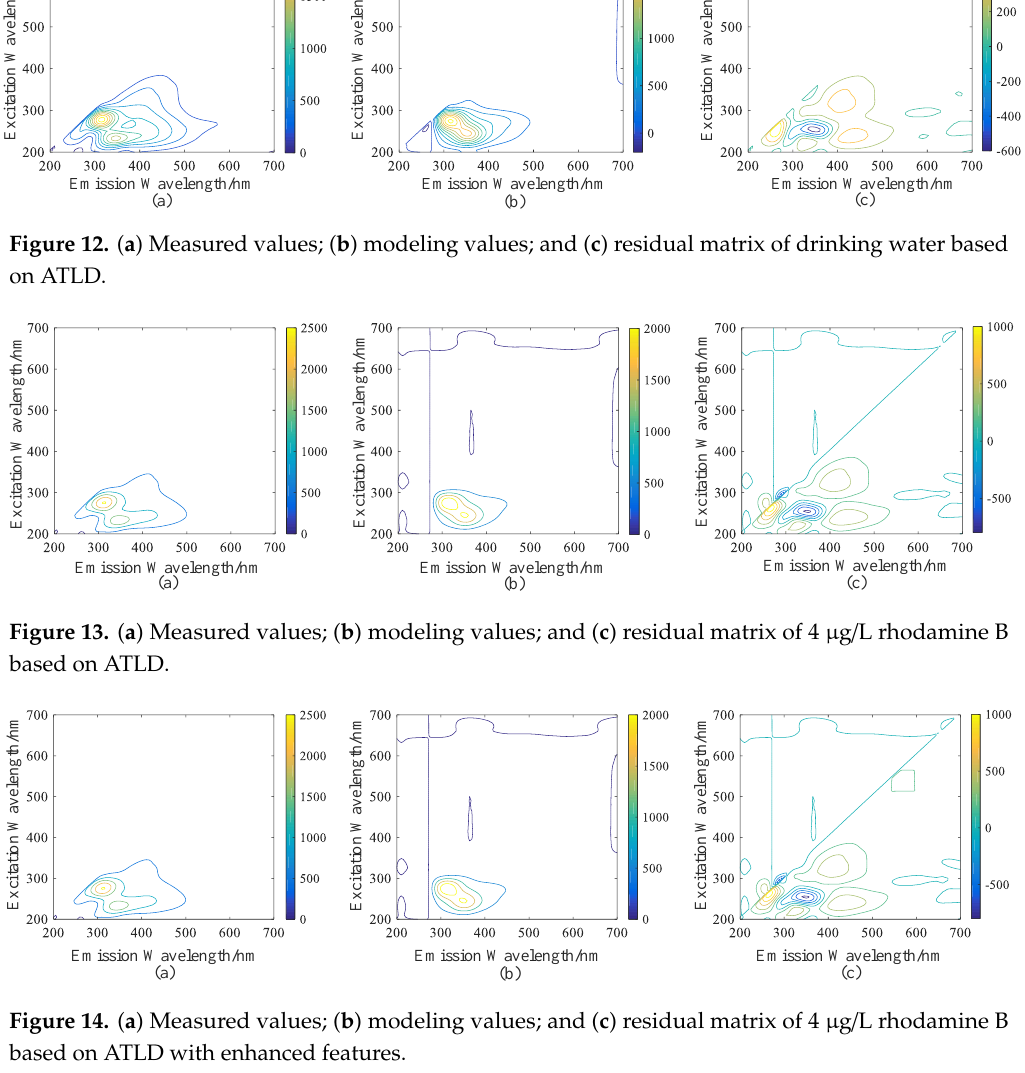
Figure 14. ( a ) Measured values; ( b ) modeling values; and ( c ) residual matrix of 4 μg/L rhodamine B based on ATLD with enhanced features.